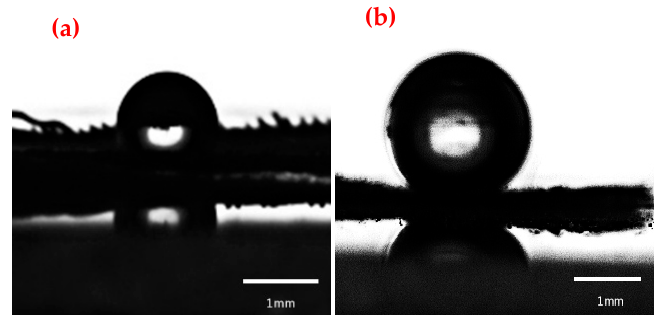
Figure 8. Wettability of water droplets on the surface of the membrane. ( a ) Untreated copper mesh; ( b ) As-prepared copper mesh.